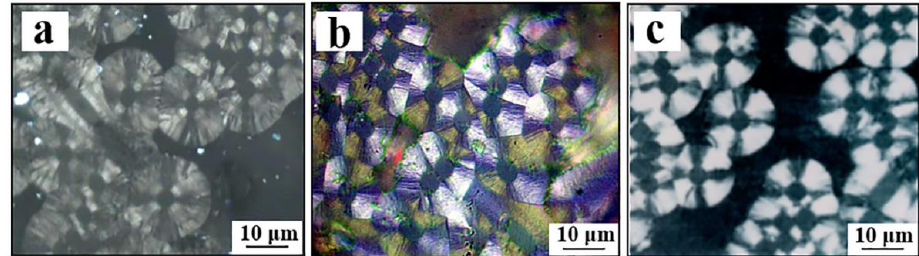
Figure 5. Pyrolytic C/C microstructures of the three different types of brake discs: ( a ) test brake disc; ( b ) commercial brake disc 1; ( c ) commercial brake disc 2. ( b ) commercial brake disc 1; ( c ) commercial brake disc